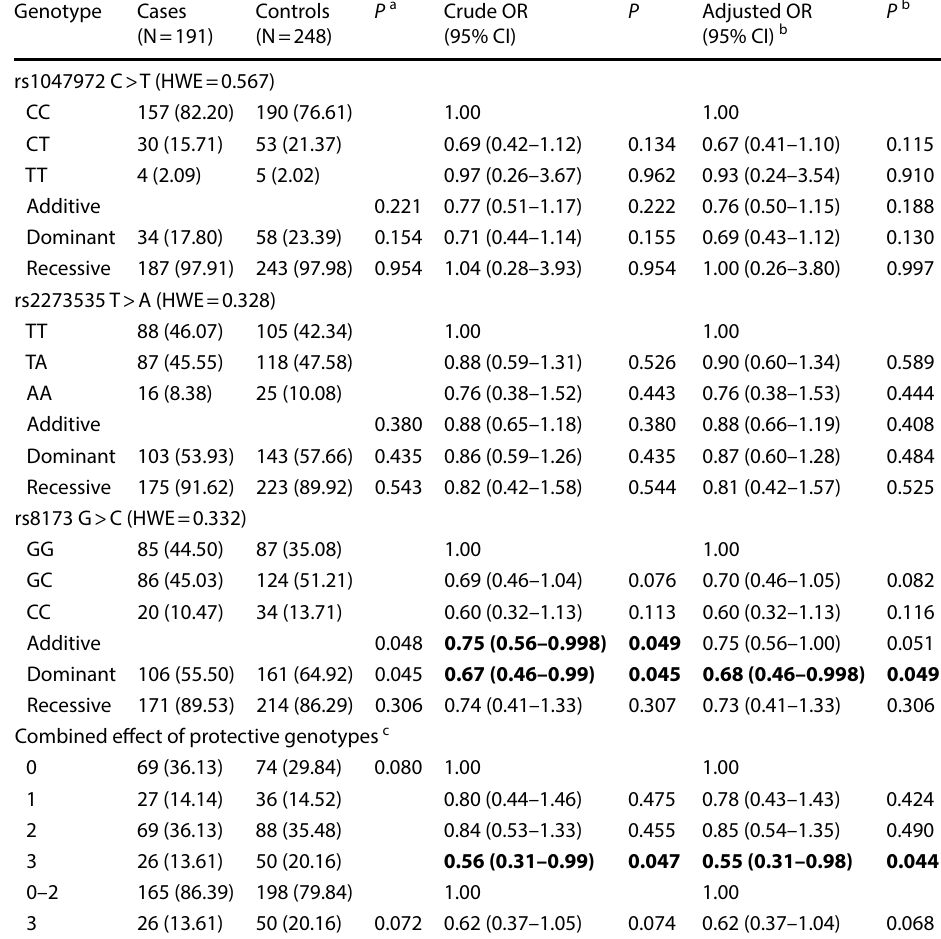
Table 1 Association between AURKA gene polymorphisms and CNS tumor susceptibility in Chinese